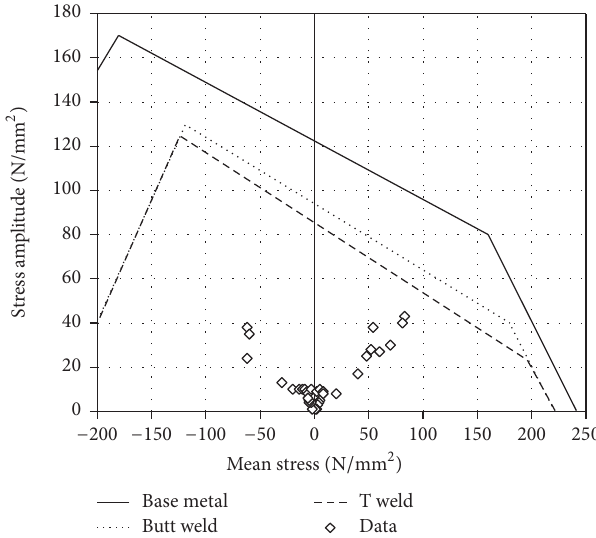
Figure 4: Goodman diagram with the results of service static load.